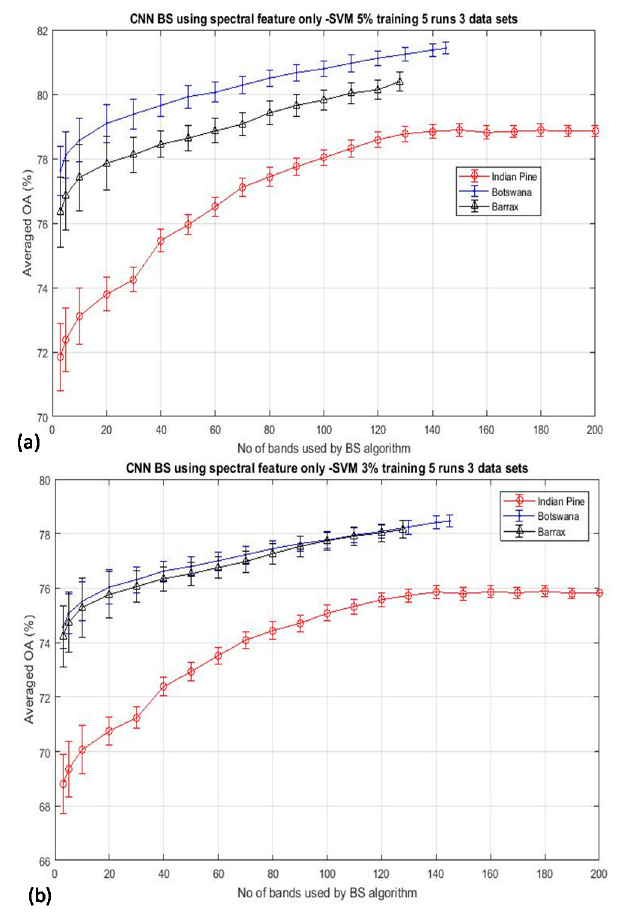
Figure 3. The mean classification accuracy of the Convolutional Neural Network (CNN) BS algorithms as a function of the number of bands used for the classification of the same datasets as in Figure 2 but with reduced training data to ( a ) 5% per class and ( b ) 3% per class. The trend of increasing the accuracy with the dimensionality under such a small amount of training data may suggest that it is not the ‘over-sufficient’ amount of training data that has been utilized here for causing the absence of the Hughes’ accuracy-dimensionality characteristic in these experiments.